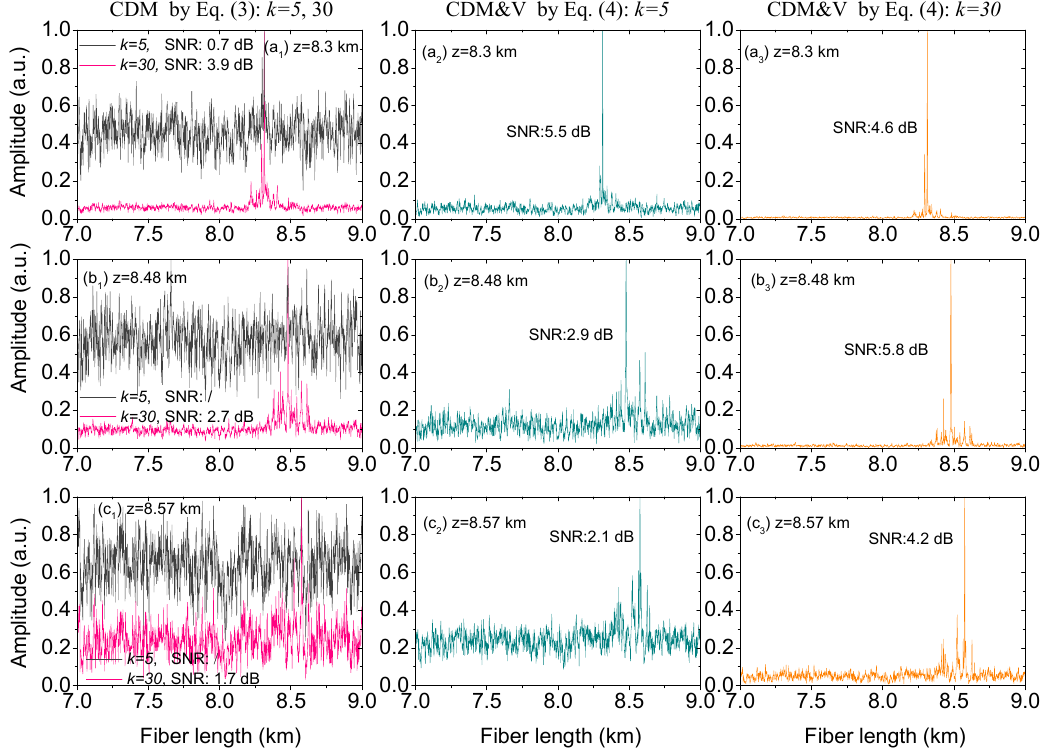
Figure 6. Synthesized signals of the vehicle by the CDM and CDM&V at di ff erent locations. ( a 1 , a 2 , a 3 ) z = 8.3 km; ( b 1 , b 2 , b 3 ) z = 8.48 m; ( c 1 , c 2 , c 3 ) z = 8.57 m. The first column is computed by the CDM based on Equation (3), and the second and third are calculated by the CDM&V based on Equation (4).